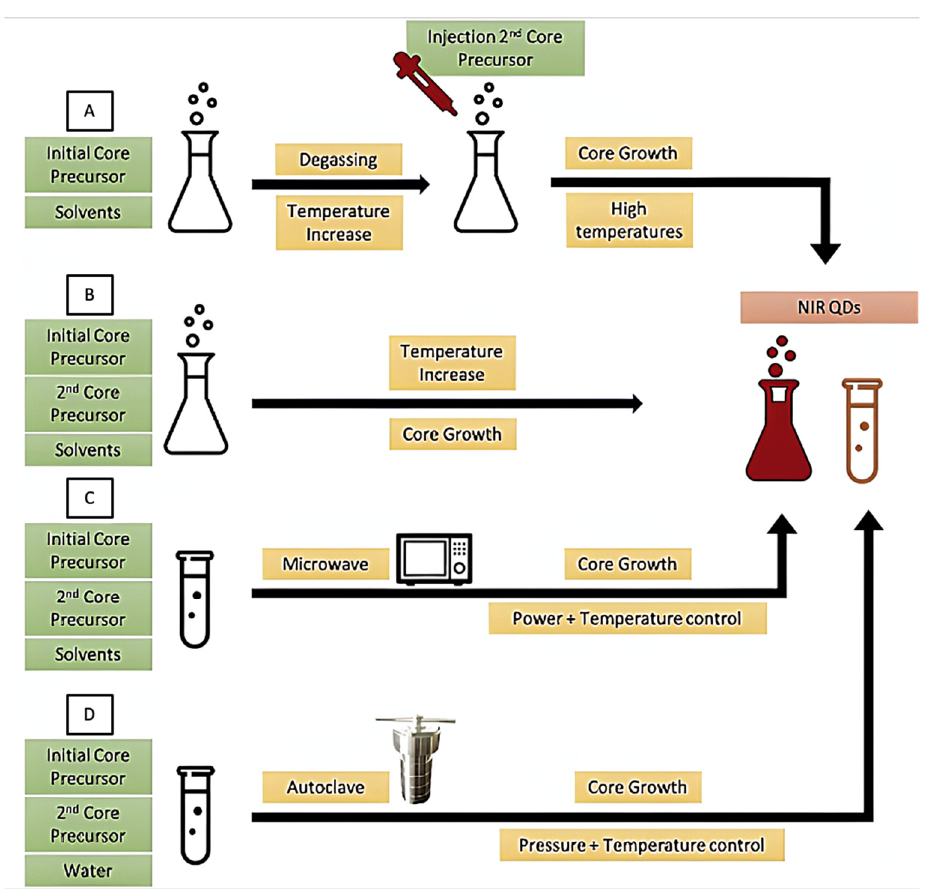
Figure 5. Methods used for QD synthesis. (A) hot-inject method; (B) heat-up approach; (C) microwave method; (D) hydrothermal method. Reprinted from Ref. [38], copyright 2021, with permission from Elsevier.